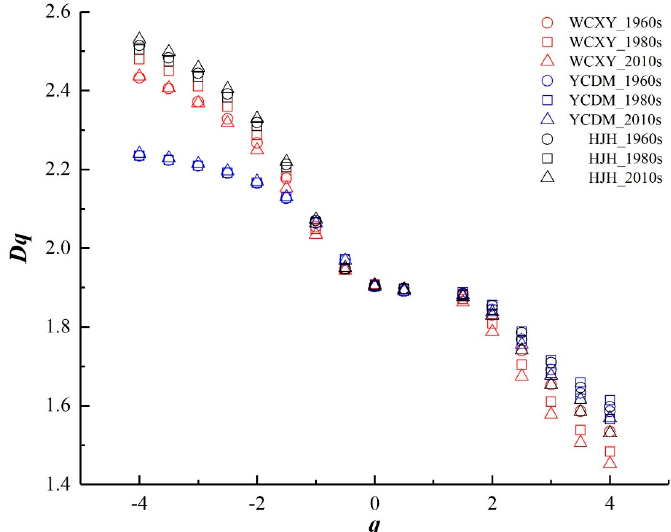
Figure 5. The relationship between multifractal dimension Dq and moment order q of three different areas: Hangjiahu (HJH), Wuchengxiyu (WCXY), and Yangchengdianmao (YCDM) in the 1960s, 1980s, and 2010s.